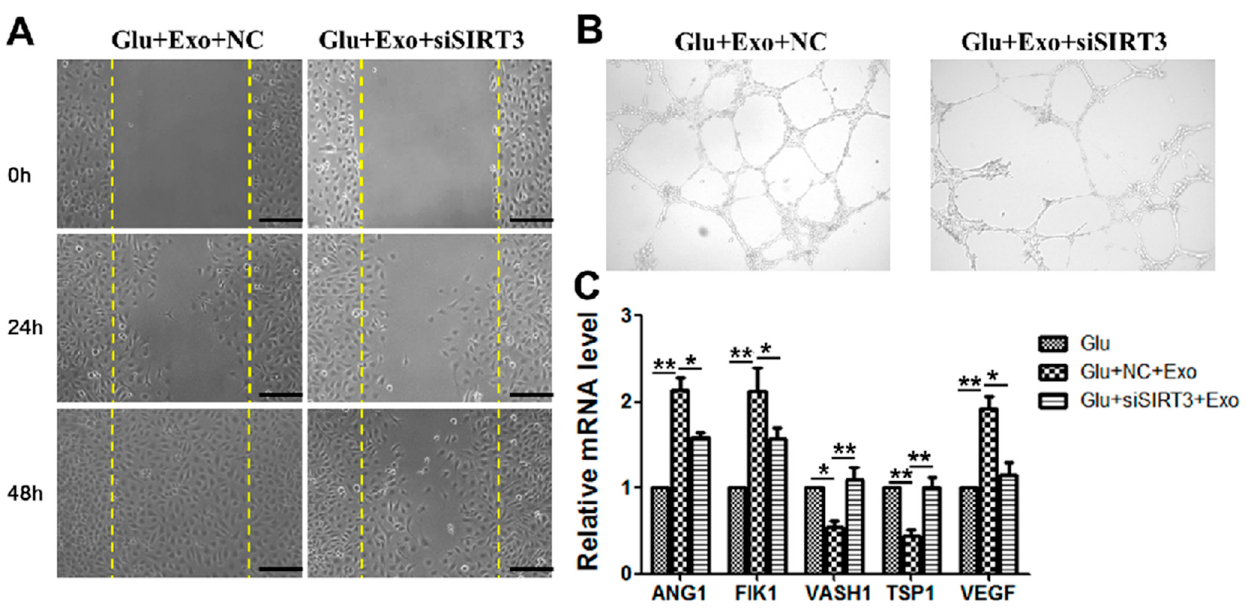
Figure 6. ADSC-exos promote the migration and angiogenesis of HUVECs via SIRT3. ( A ) The effect of SIRT3 on HUVECs migration was examined by scratch wound assays. The images show the wound area in each group at 0 h, 24 h, and 48 h (scale = 250 μ m). ( B ) Angiogenesis in different groups of HUVECs. The results showed that siSIRT3 reduced HUVECs angiogenesis. ( C ) mRNA levels of angiogenesis factors (ANG1, FILK1, and VEGF) and angiogenesis inhibitors (VASH1 and TSP1) were analyzed by qRT-PCR. The data are shown as the mean ± SD (* p < 0.05, ** p < 0.01).